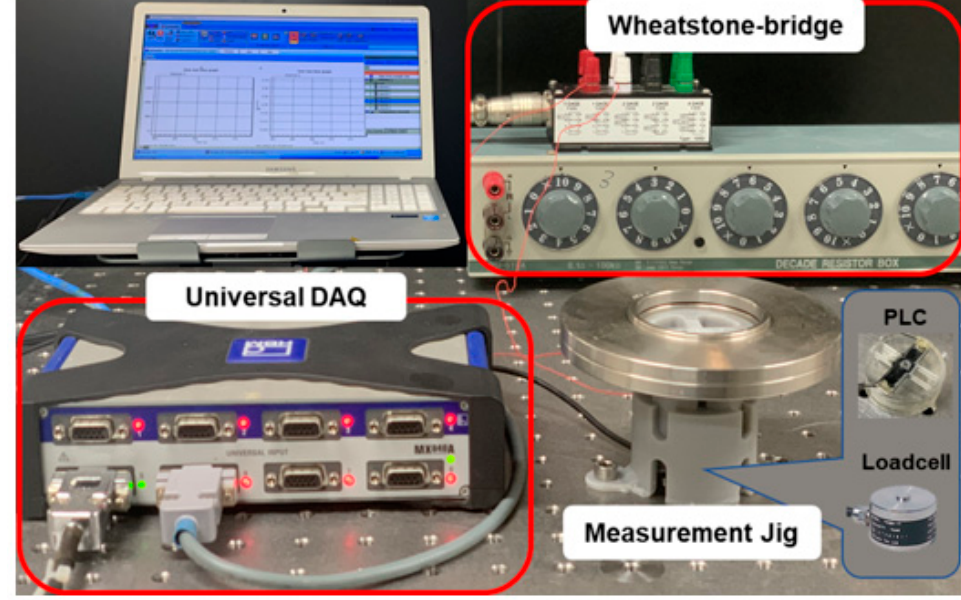
Figure 6. Experimental apparatus with a 3D printed jig and a data acquisition system.